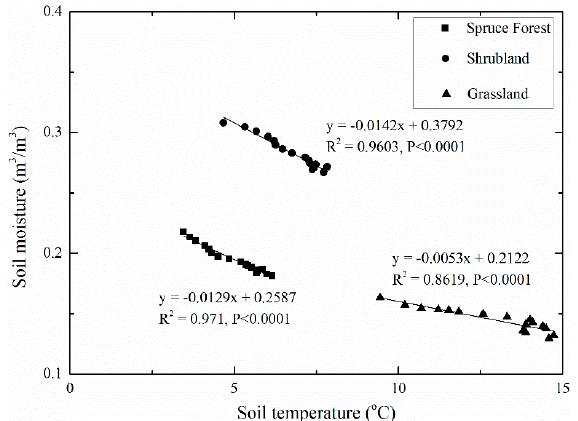
Figure 9. The regression relationship between average soil moisture and average soil temperature at the surface soil (0–40 cm) under three vegetation types.